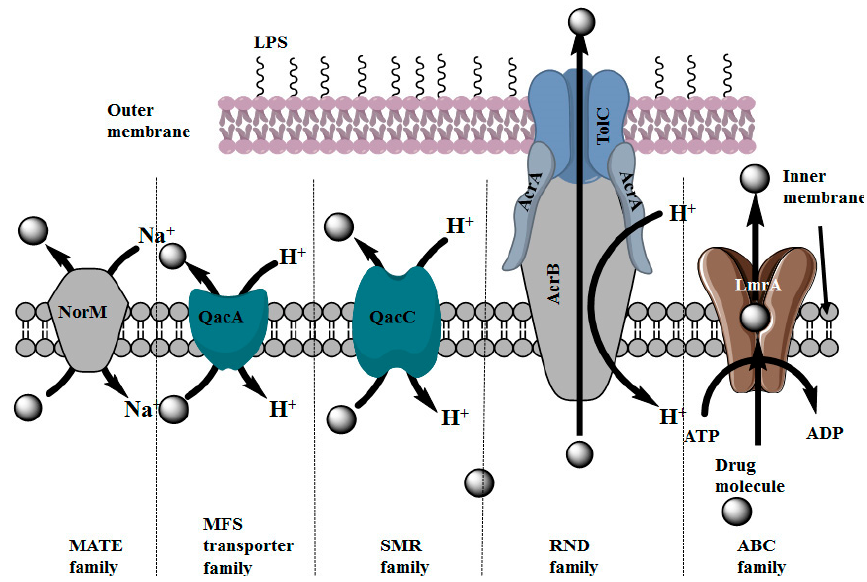
Figure 3. Schematic diagram representing different types of drug transporters present in microorganisms [27–33].